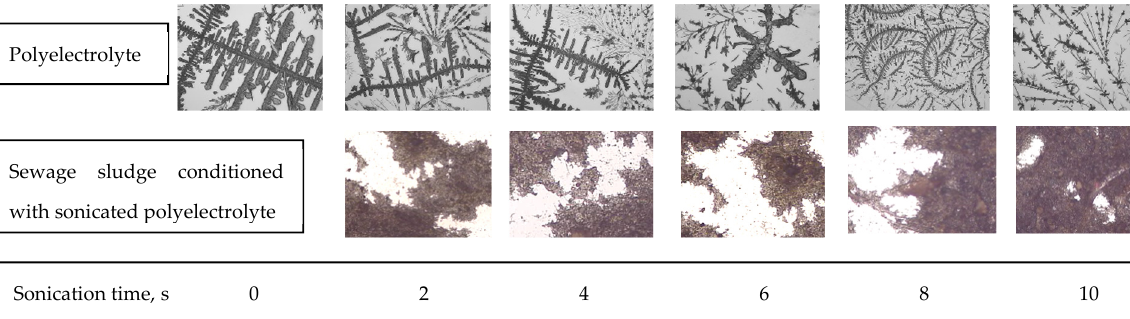
Figure 7. Structure of modified polyelectrolyte and sewage sludge conditioned with sonicated polyelectrolyte.